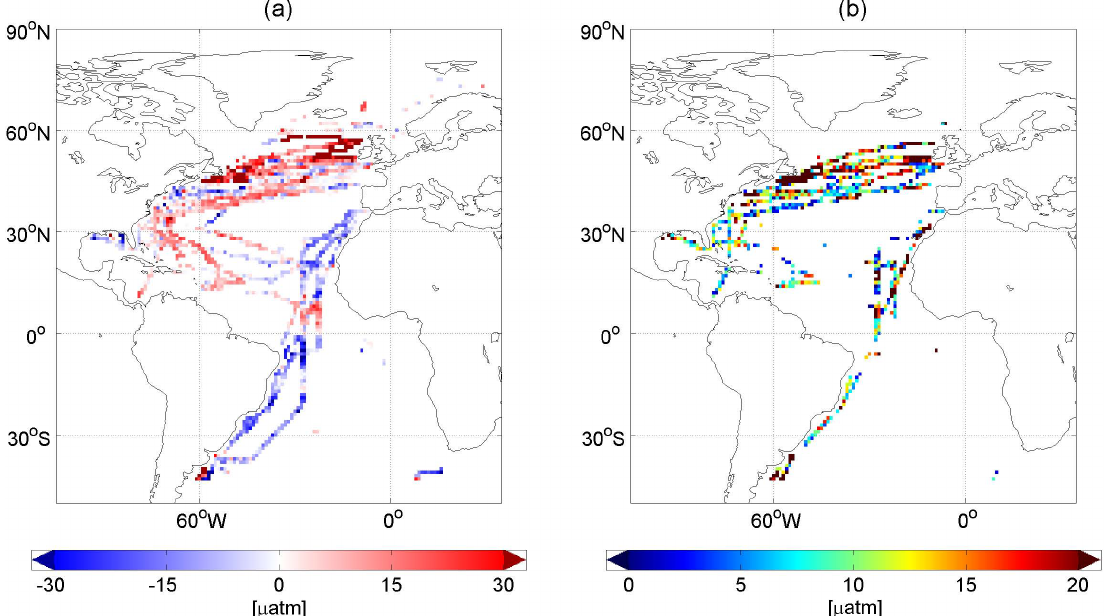
Fig. 5. (a) Temporal mean residuals and (b) standard deviation of the residuals in µatm between neural network estimates and independent data points obtained from the SOCAT v2 gridded observations (Bakker et al., 2013) for the period from 1998 to 2007. Pixels that have a value in (a) but not in (b) indicate where only 1 observation in time is available.